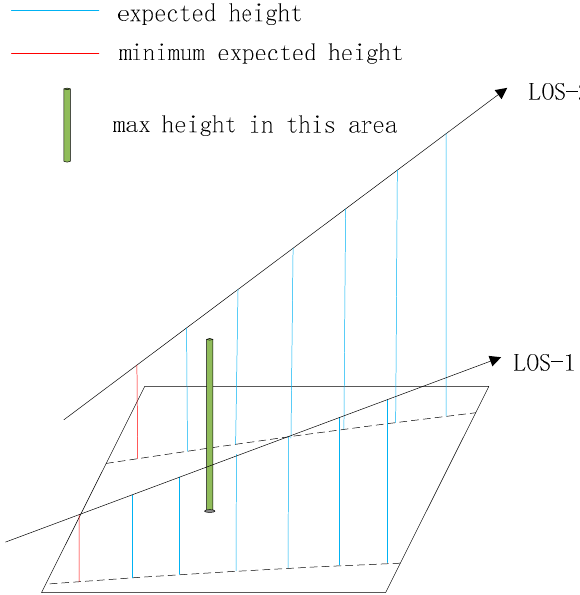
Figure 9. Expected height and minimum expected height in an area bounded by the parallelogram.